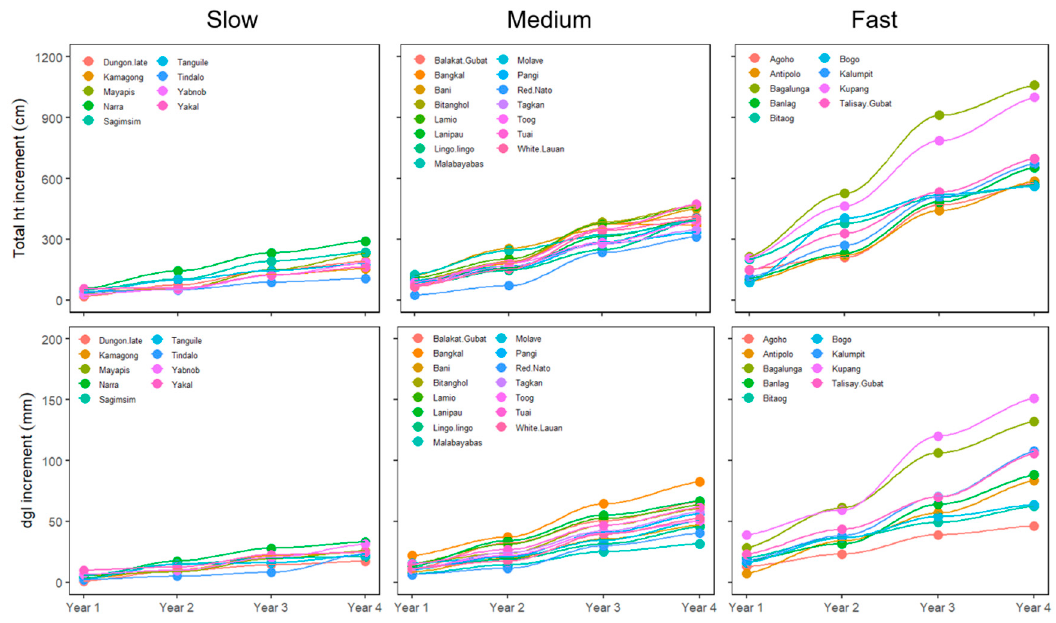
Figure 5. Cumulative height and dgl increments of 33 native species from Year 1 to Year 4. Each graph represents the species by cluster (slow, medium, and fast). Increments were taken based from previous year measurement. Data point and incremental line for each species within a cluster are represented by different colors.